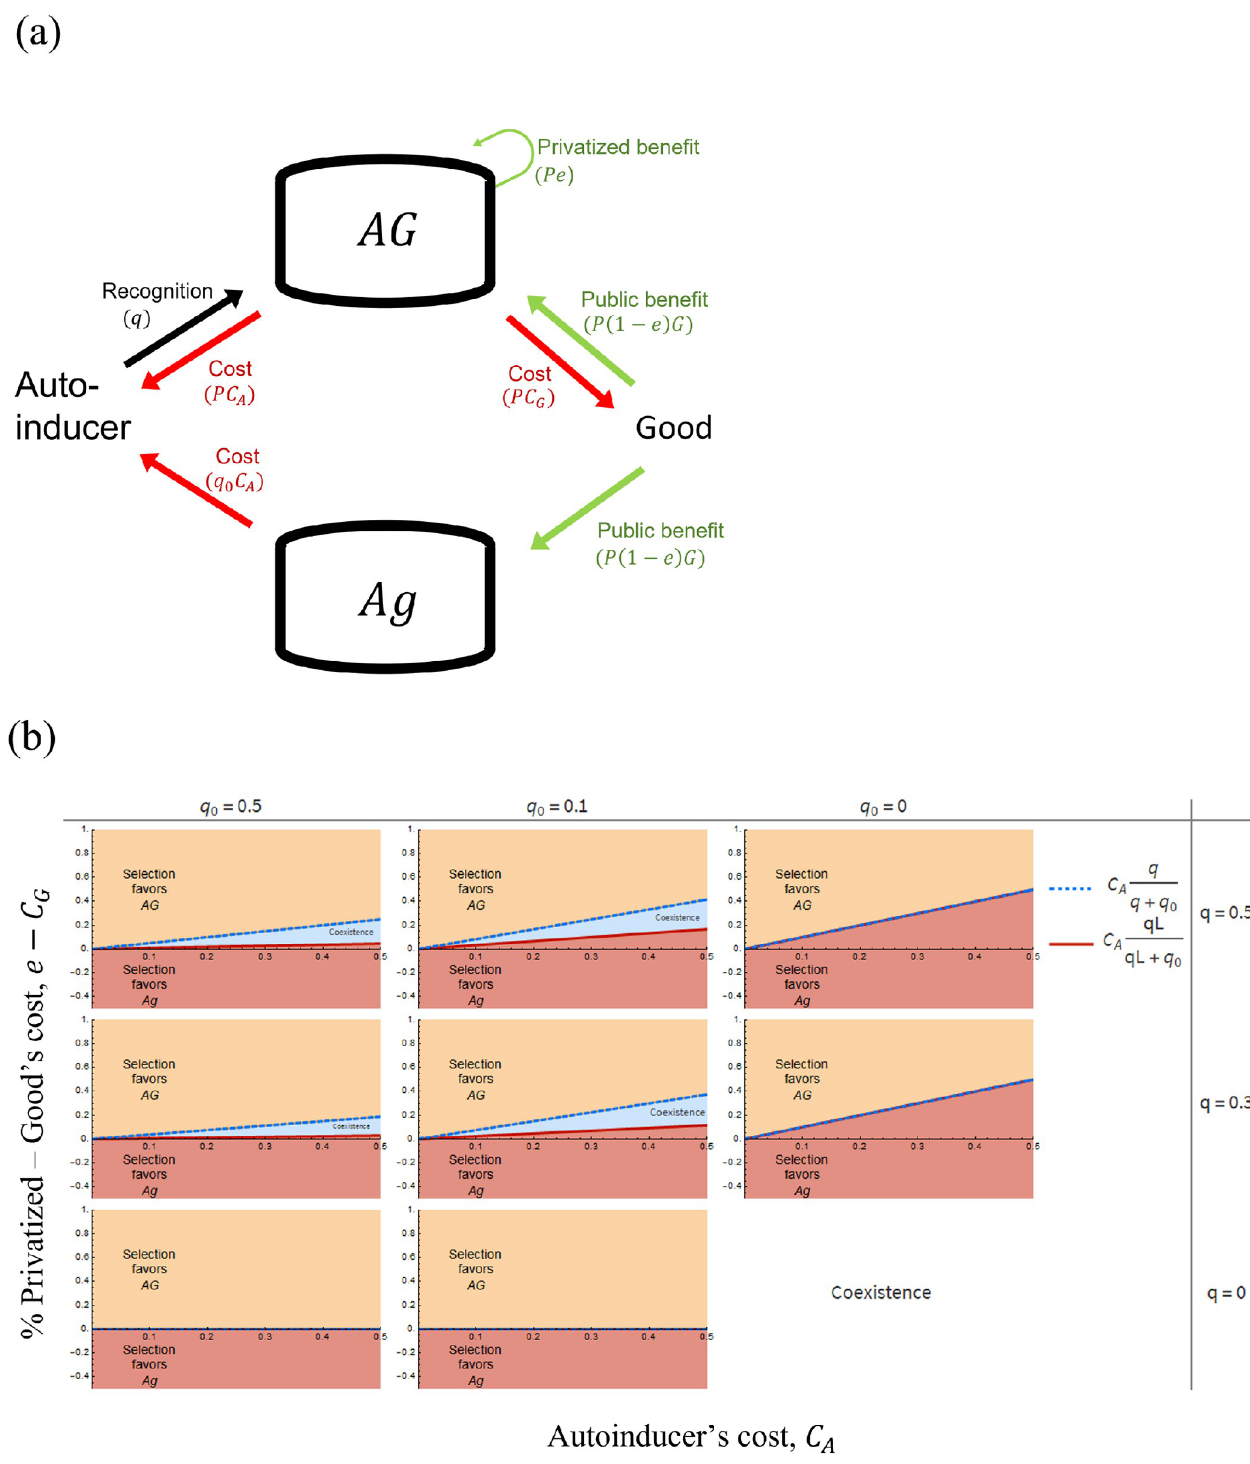
Fig 2. The partially privatized benefit favors QS through pure populations of AG or through mixed populations of AG and Ag . (a) A schematic social interaction between strains AG and Ag . (b) Selection either favors (i) pure populations of AG (yellow area); (ii) pure populations of Ag (red area); (iii) coexistence of AG and Ag (blue area). Selection favors the coexistence if the rare strain outcompetes the common one (i.e., negative frequency-dependent selection). The frequency of each strain within the blue is not uniform (S1 Fig). Negative frequency-dependent selection emerges from the co-regulation of QS ( q ) and QS-independent ( q 0 ) mechanisms, the existence of privatization ( e ) and having privatized benefits offsetting the minimum autoinducer’s cost,